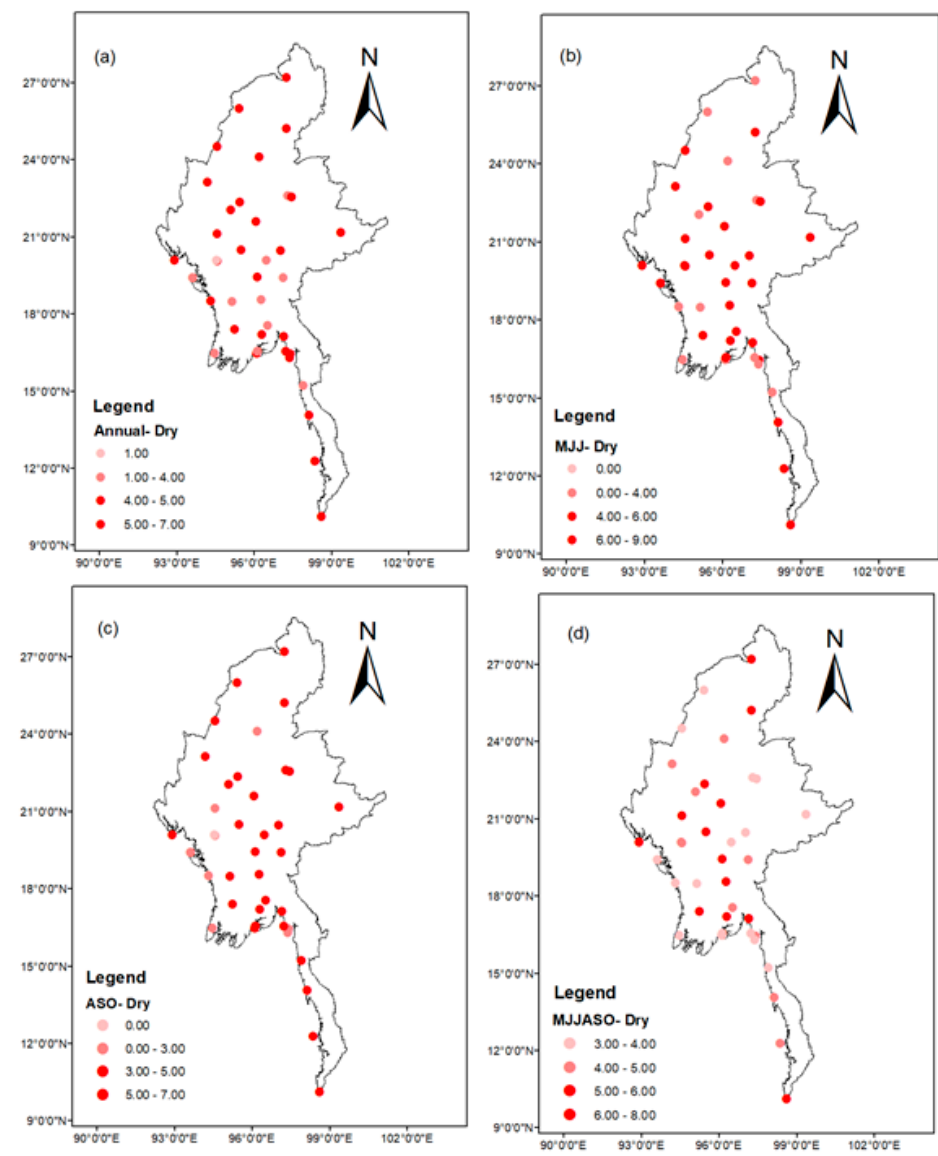
Figure 7. Frequency of drought occurrence of dry spells over Myanmar from 1986 to 2015. ( a ) Annual, ( b ) MJJ, ( c ) ASO, ( d ) MJJASO. Taking MJJ as an example, fewer dry spells than wet spells persisted with varying frequencies (Figures 7b and 8b). In ASO, the frequency of dry spells is found in nearly the entire country, with deltaic, western, and eastern hilly zones showing a more pronounced frequency of dry spells. In contrast, wet spells in ASO (Figure 8c) showed similar spatial patterns to Figure 7c (MJJ wet spells), but with significant frequency values. In the monsoon season, the frequency of dry spells was high (4–7 times) in most areas from deltaic, western, and eastern hilly zones compared with wet spells in both space and